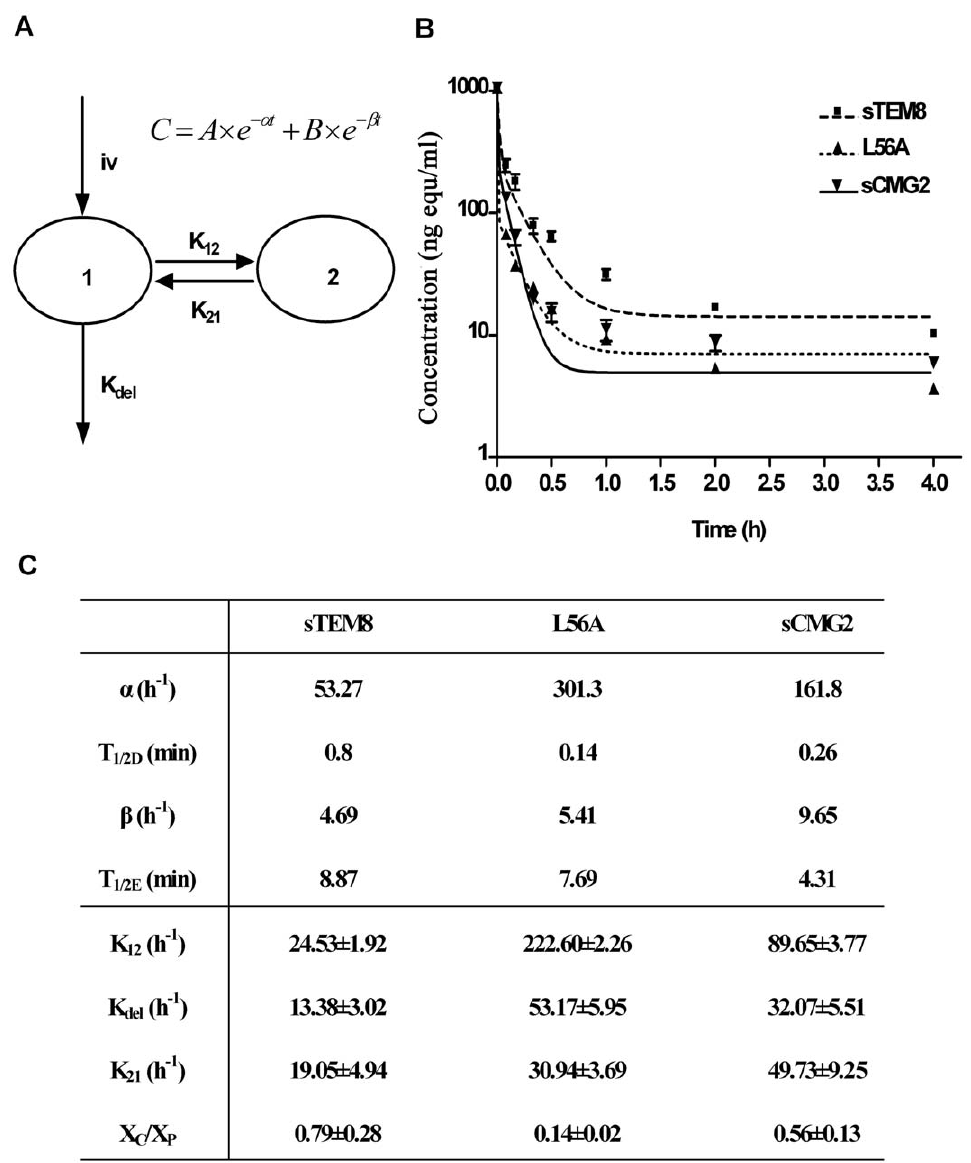
Figure 4. Pharmacokinetics of the variants. A . Schematic diagram of the two-compartment model, which is generally used for protein drugs administered i.v. by pulse injection. The two compartments are divided based on the different pharmacokinetic rates with the central compartment (denoted as compartment 1) representing the vascular cavity and the peri-compartment (denoted as compartment 2) representing relatively compact tissues. The elimination was limited in compartment 1 for simplification. The model can then be symbolized as C ~ A (cid:2) e { a t ð Þ z B (cid:2) e { b t ð Þ . B . Plasma concentration-time plots of receptor decoys after i.v. injection into rats (n=6) at a dose of 67.5 m g/kg. The point at time 0 was plotted based on a deduced initial concentration of 105 ng/ml, which equaled the injection amount (13.5 m g for 200 g on average) divided by the theoretical circulating blood volumes (12.8 ml for 200 g on average) [32]. Analysis applied the two-compartment model. Profiles are fitted by a two-phase exponential decay equation (GraphPad Prism software, San Diego California USA) with constraints of a . 1, b . 1, and values shared. C . Related pharmacokinetic parameters. Values for a , b were calculated by fitting plots in Fig. 4B with a two-phase exponential decay equation Y ~ A (cid:2) e { a X ð Þ z B (cid:2) e { b X ð Þ z Plateau (GraphPad Prism software, San Diego California USA), with constraints of a . 1, b . 1, and values shared. Values for half time were calculated as 0.69/ a and 0.69/ b . The first degradation rate constants were calculated by K 21 ~ K 12 ~ a z b { K 21 { K del . K 21 , and K 12 represents the crossing rate between compartments, and K del represents the excretion rate out of the system, as symbolized in figure 4A. X C /X P represents the ratio of drug amount distributed in the central compartment to that of the peri-compartment at equilibrium, which equaled K 21 /K 12 .